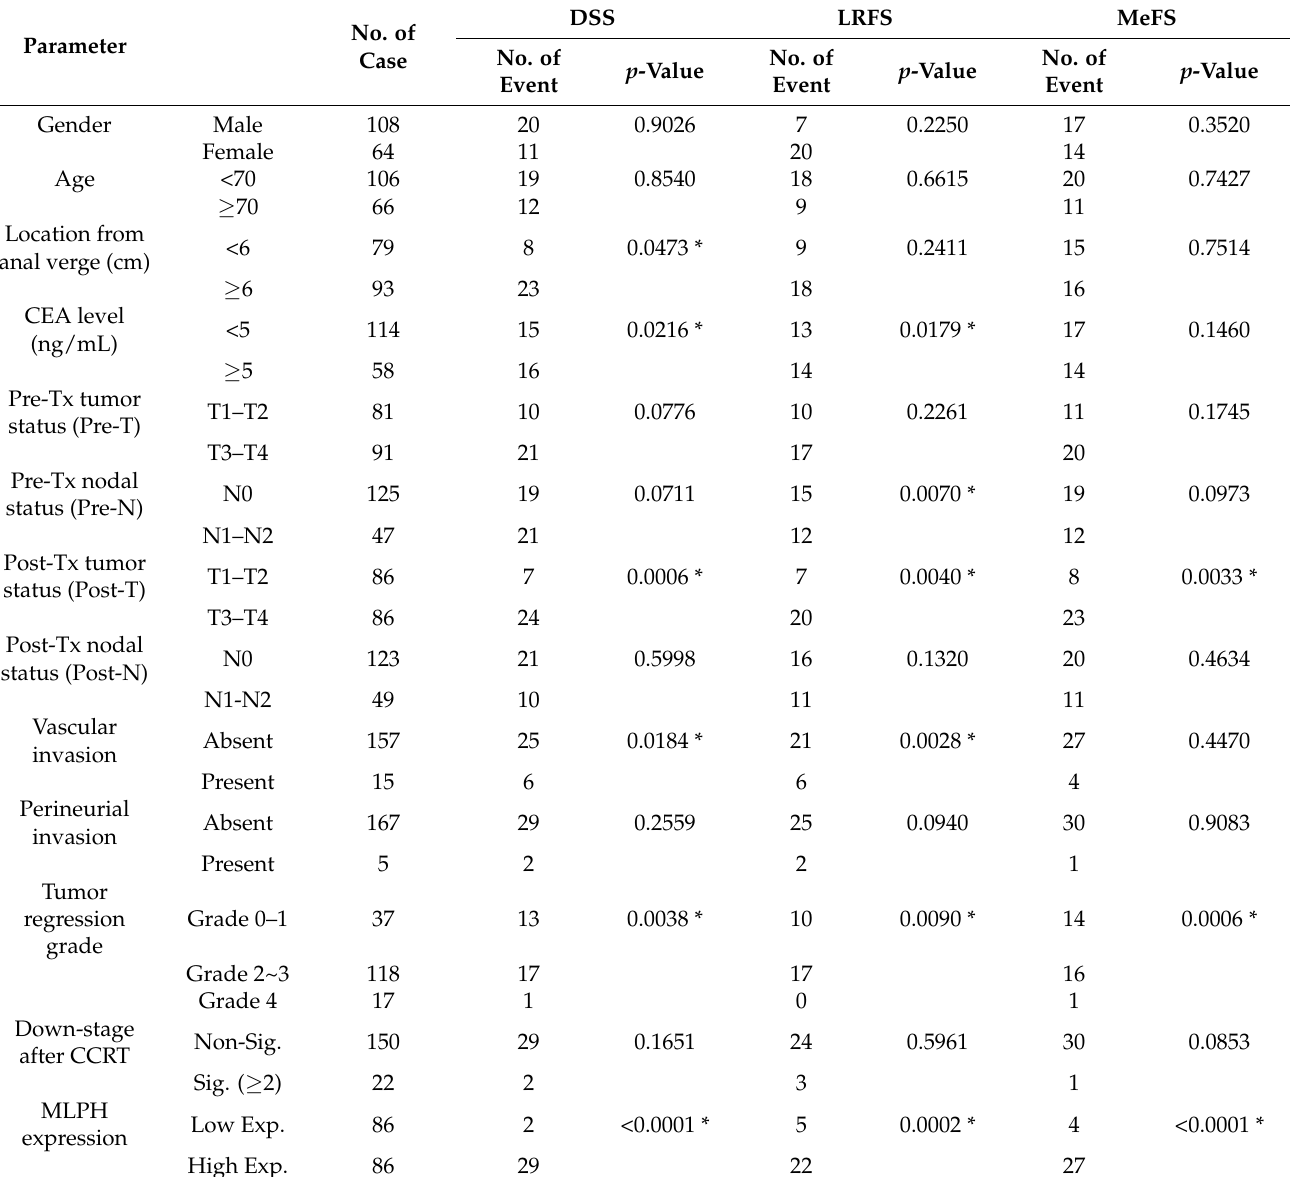
Table 3. Univariate log-rank analysis for important clinicopathological variables and MLPH